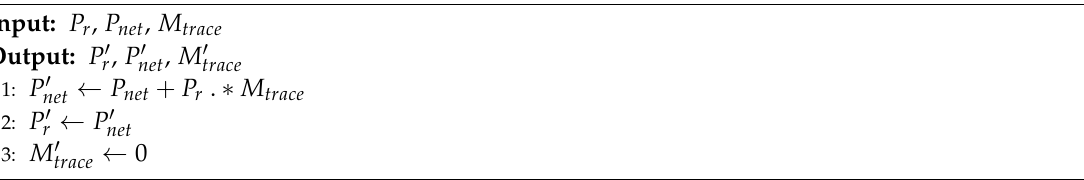
Algorithm 2 Update pheromone matrix when visiting a communication